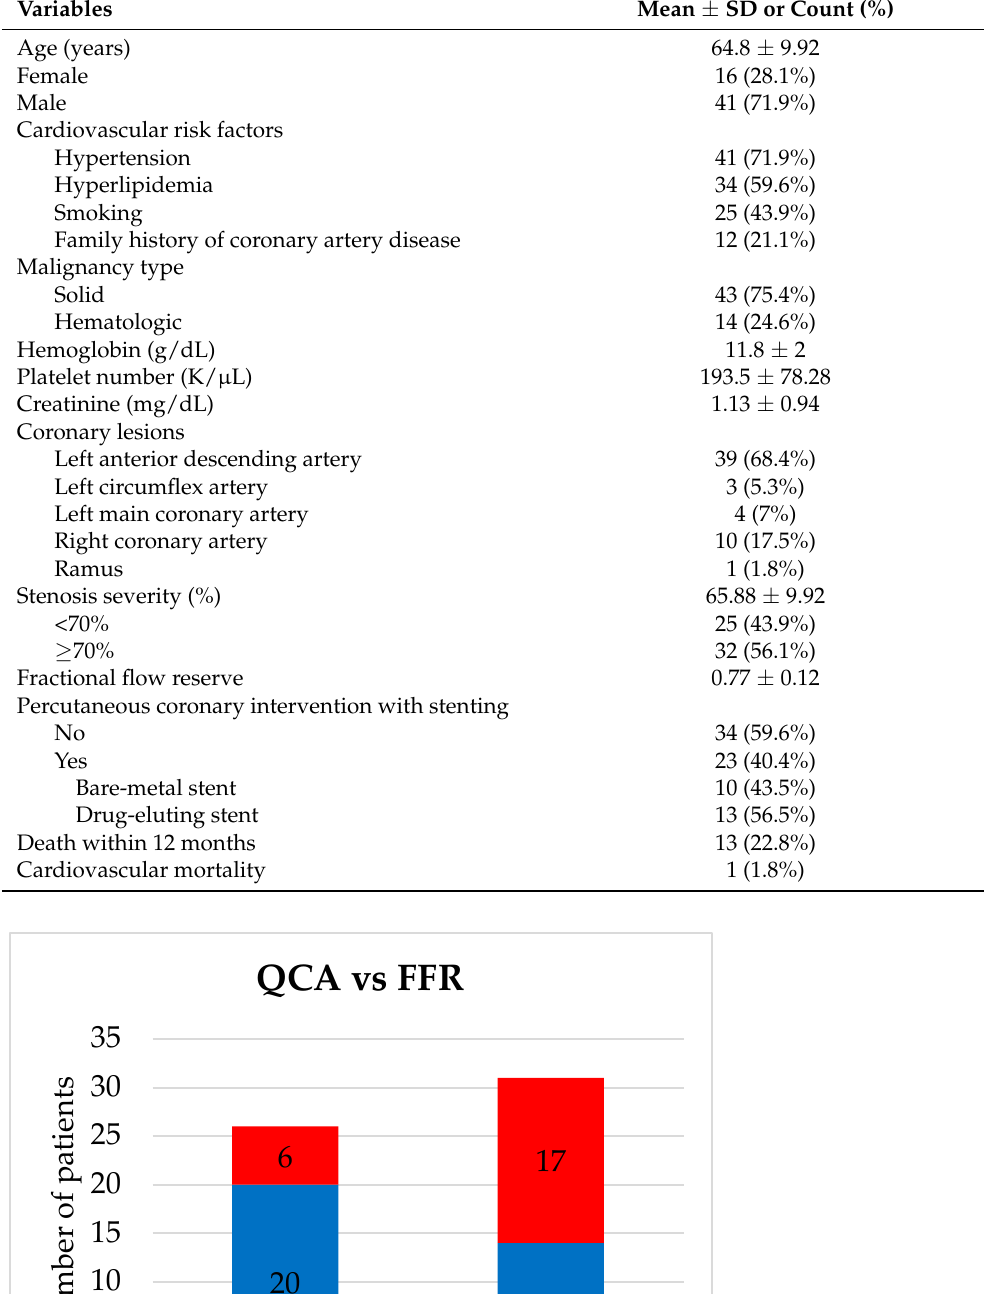
Table 1. Descriptive statistics for the entire group (n = 57).